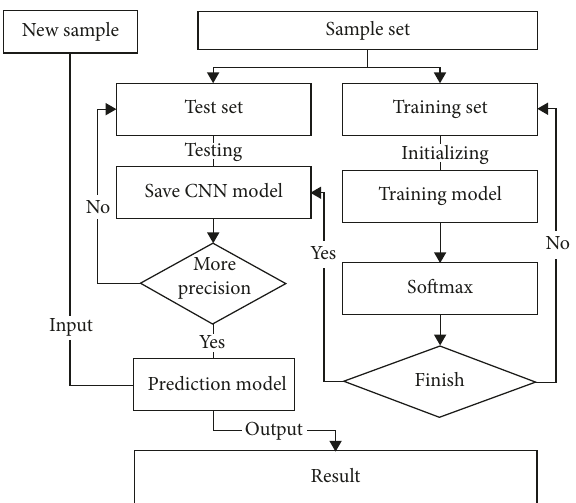
Figure 3: Flowchart of CNN model evaluation.